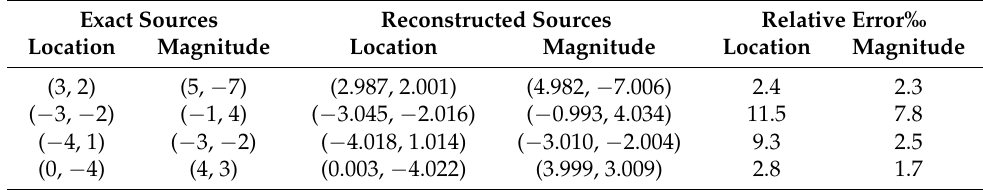
Table 2. Reconstruction of four single sources from far-field data in 2D.